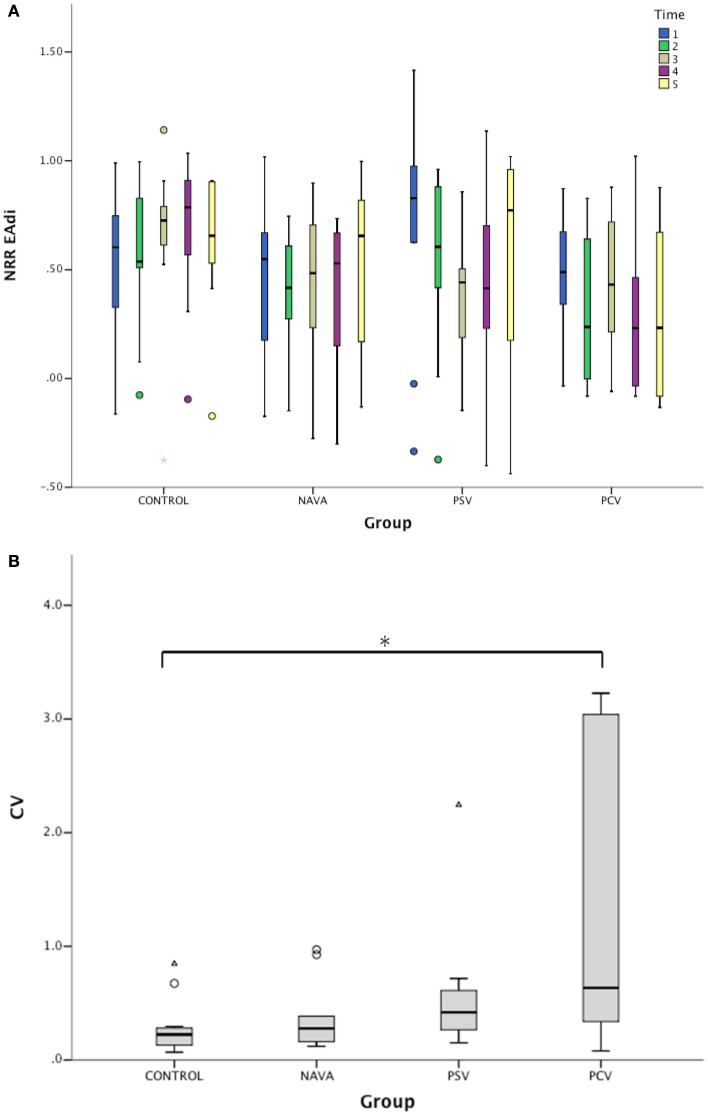
(A) Variation of non-rhythmic to rhythmic (NRR) index during the five consecutive 2-min periods for electrical activity of the diaphragm (EAdi) signal in infants without ventilatory support (control) and during mechanical ventilation in neurally adjusted ventilatory assist (NAVA), pressure support ventilation (PSV), and pressure-controlled ventilation (PCV). NRR EAdi, arbitrary units. (B) Corresponding intra-patient coefficients of variation (CV) of NRR for EAdi signal. Median [25–75%]. *p < 0.05 vs. control.